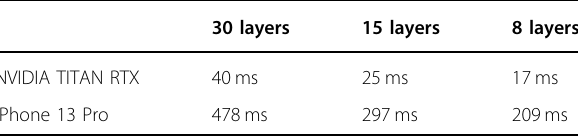
Table 3 Runtime performance of TensorHolo V2 RGB-D CNNs on GPU and iPhone 13